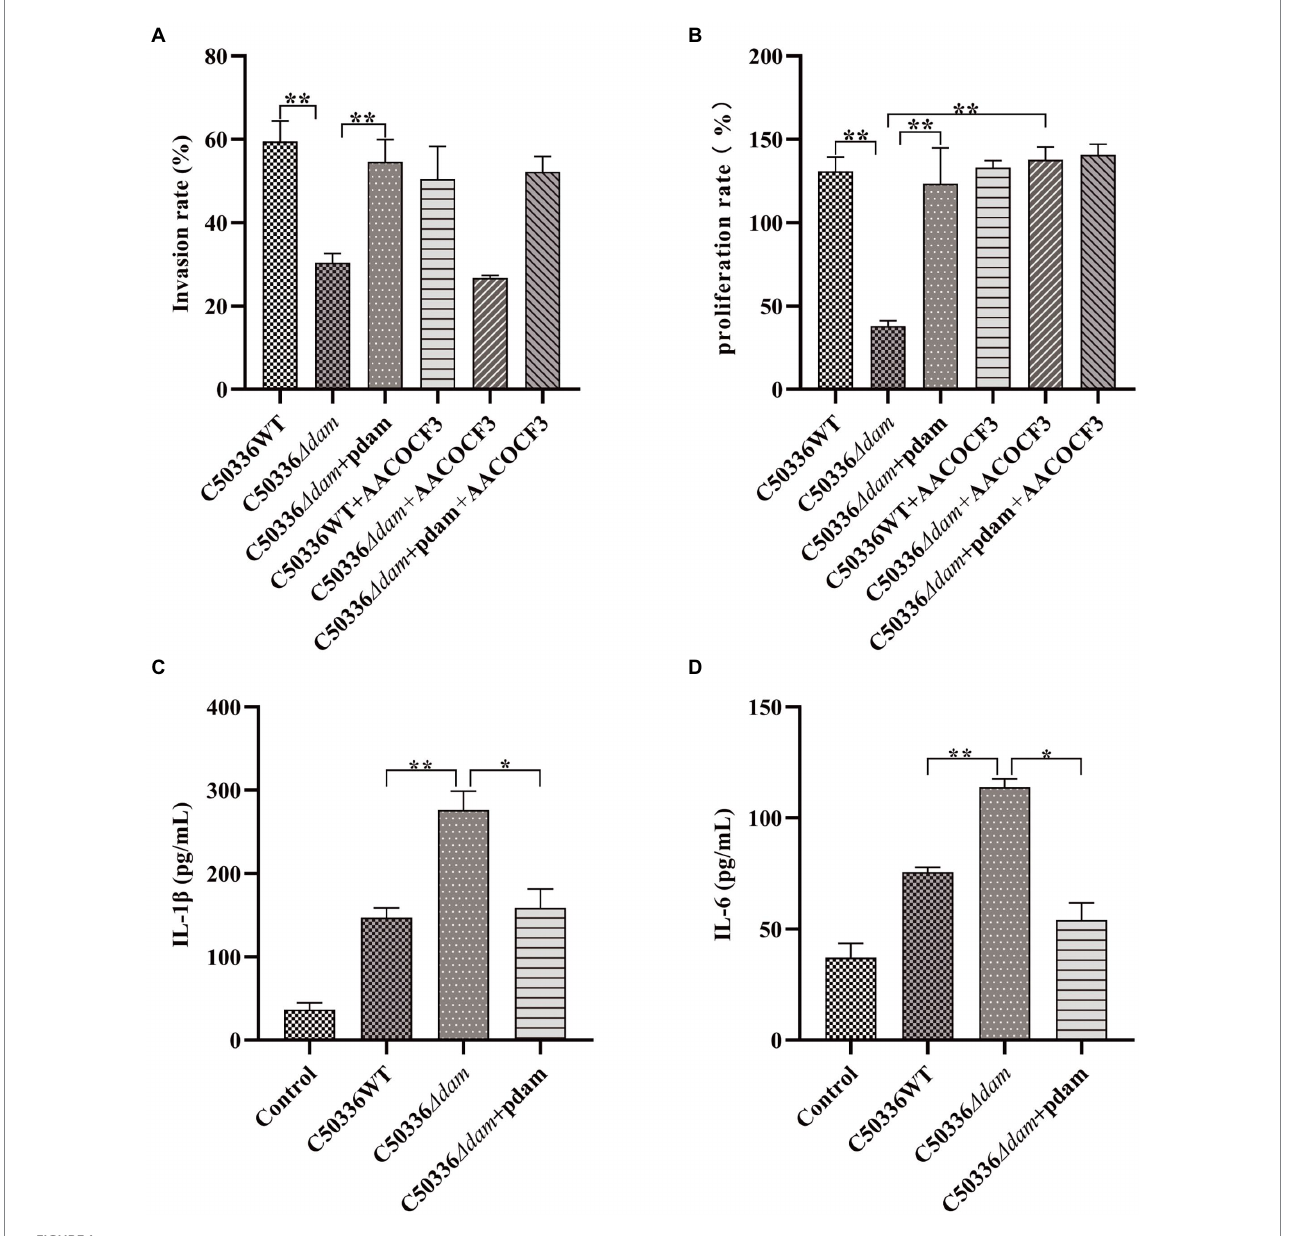
FIGURE 1 The dam gene promotes invasion and proliferation and inhibits secretion of IL-1 β and IL-6. (A) Invasion rate of C50336WT, C50336 Δ dam, and C50336 Δ dam + pdam in J774A.1 and inhibiting the intracellular AA metabolism pathway of J774A.1 by adding AACOCF3 (15 μ M). (B) Proliferation rates of C50336WT, C50336 Δ dam, and C50336 Δ dam + pdam in J774A.1 and inhibiting the intracellular AA metabolism pathway of J774A.1 by adding AACOCF3